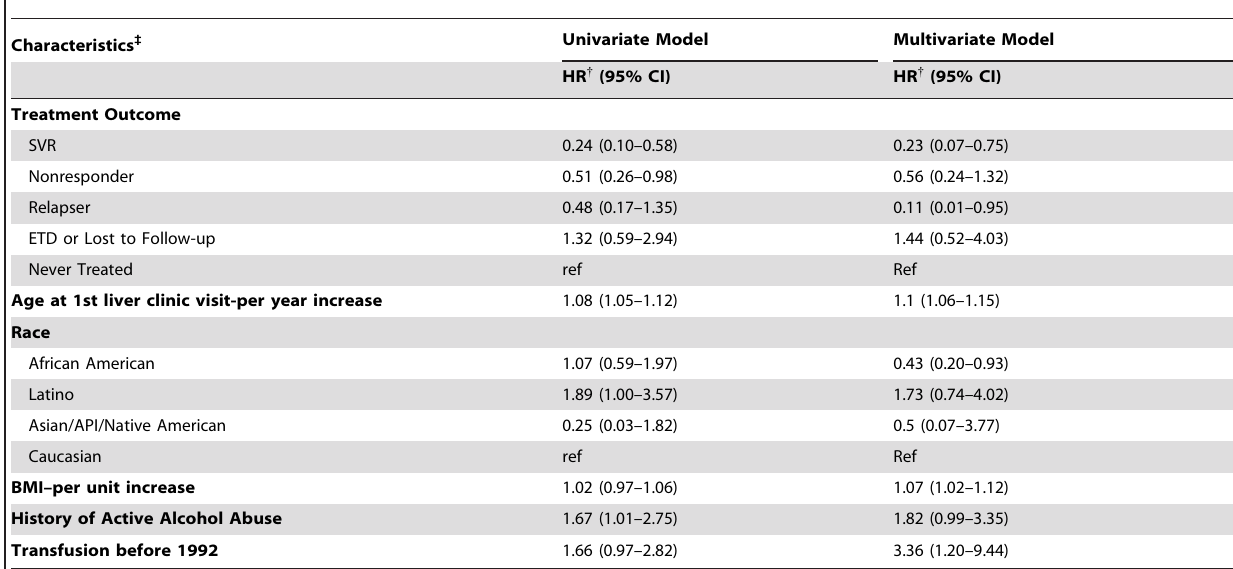
*Cox Proportional Hazards Models. { Hazard Ratio (HR) calculated using Cox Proportional Hazards Modeling. ` Interaction terms not shown.